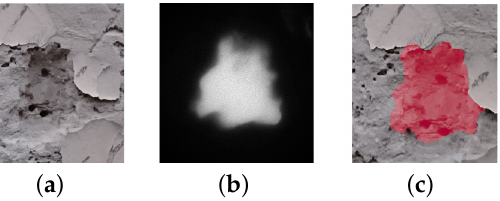
Figure 4. Exemplary segmentation of a spalling defect. ( a ) cropped part of the inspection photo. ( b ) spalling map. ( c ) overlay of the indentified spalled region and the inspection photo.